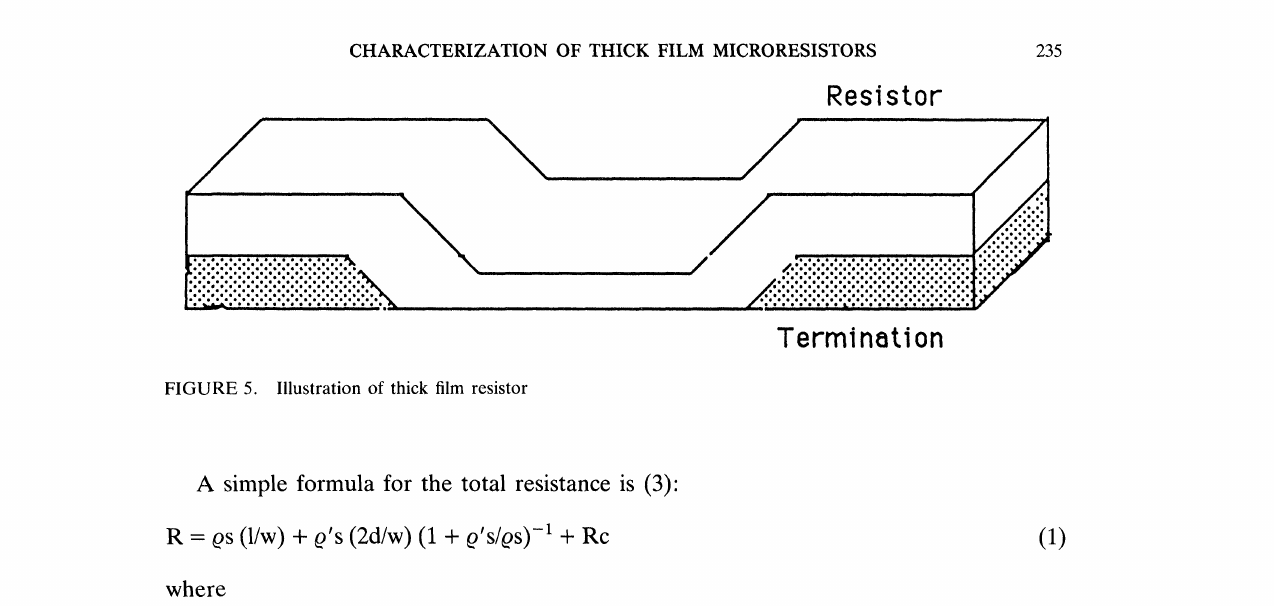
FIGURE 5. Illustration of thick film